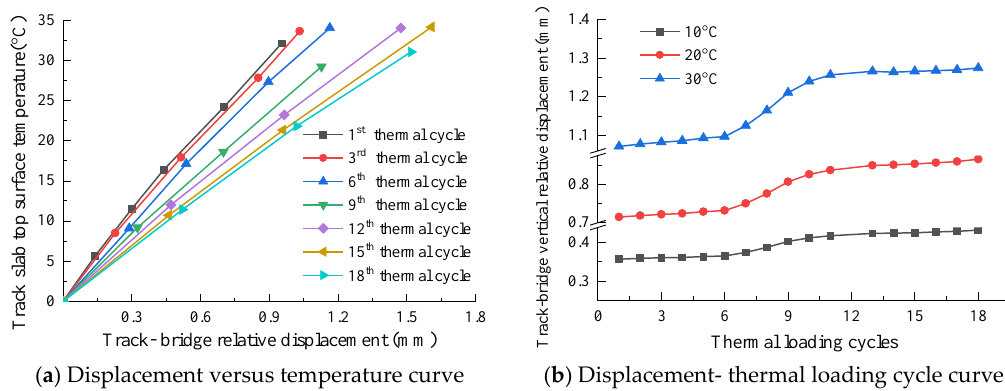
Figure 19. Track- bridge mid-span relative displacement.